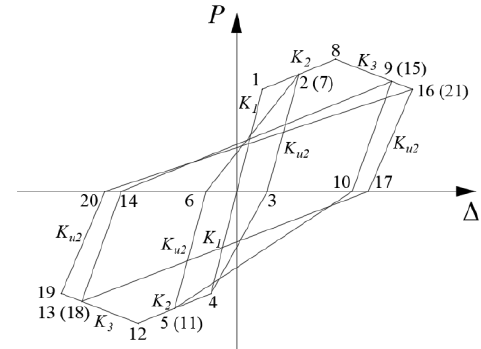
Figure 24. Hysteretic rule.